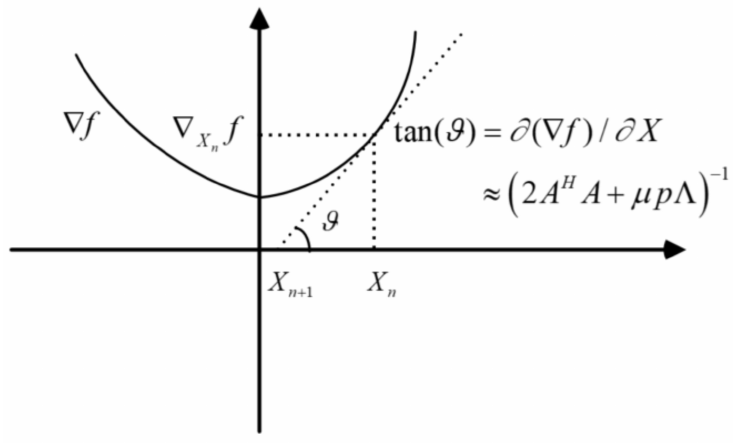
Figure 3. The geometric explanation of the iterative operation. Table 1. The steps of the proposed sparse imaging algorithm. 3D Sparse SAR Direct Imaging with Irregular